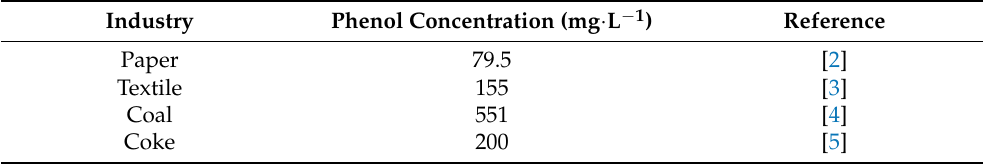
Table 1. The concentration of phenolic compounds found in the wastewater of some industries.